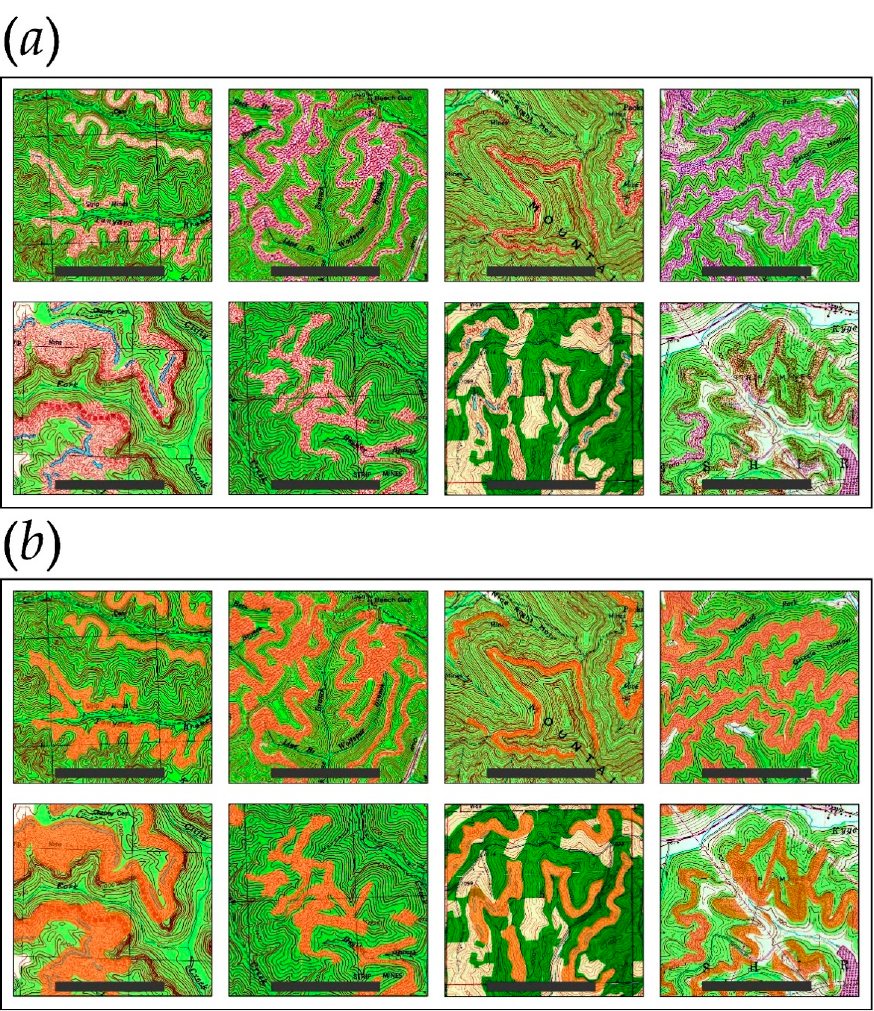
Figure 4. Example of input data. ( a ) shows examples of surface mine features as represented on the historic topographic maps. ( b ) orange areas represent the mapped extent of historic mining provided by the USGS Geology, Geophysics, and Geochemistry Science Center (GGGSC) and used as training data in this study. Scale bars represent a distance of 1 kilometer.